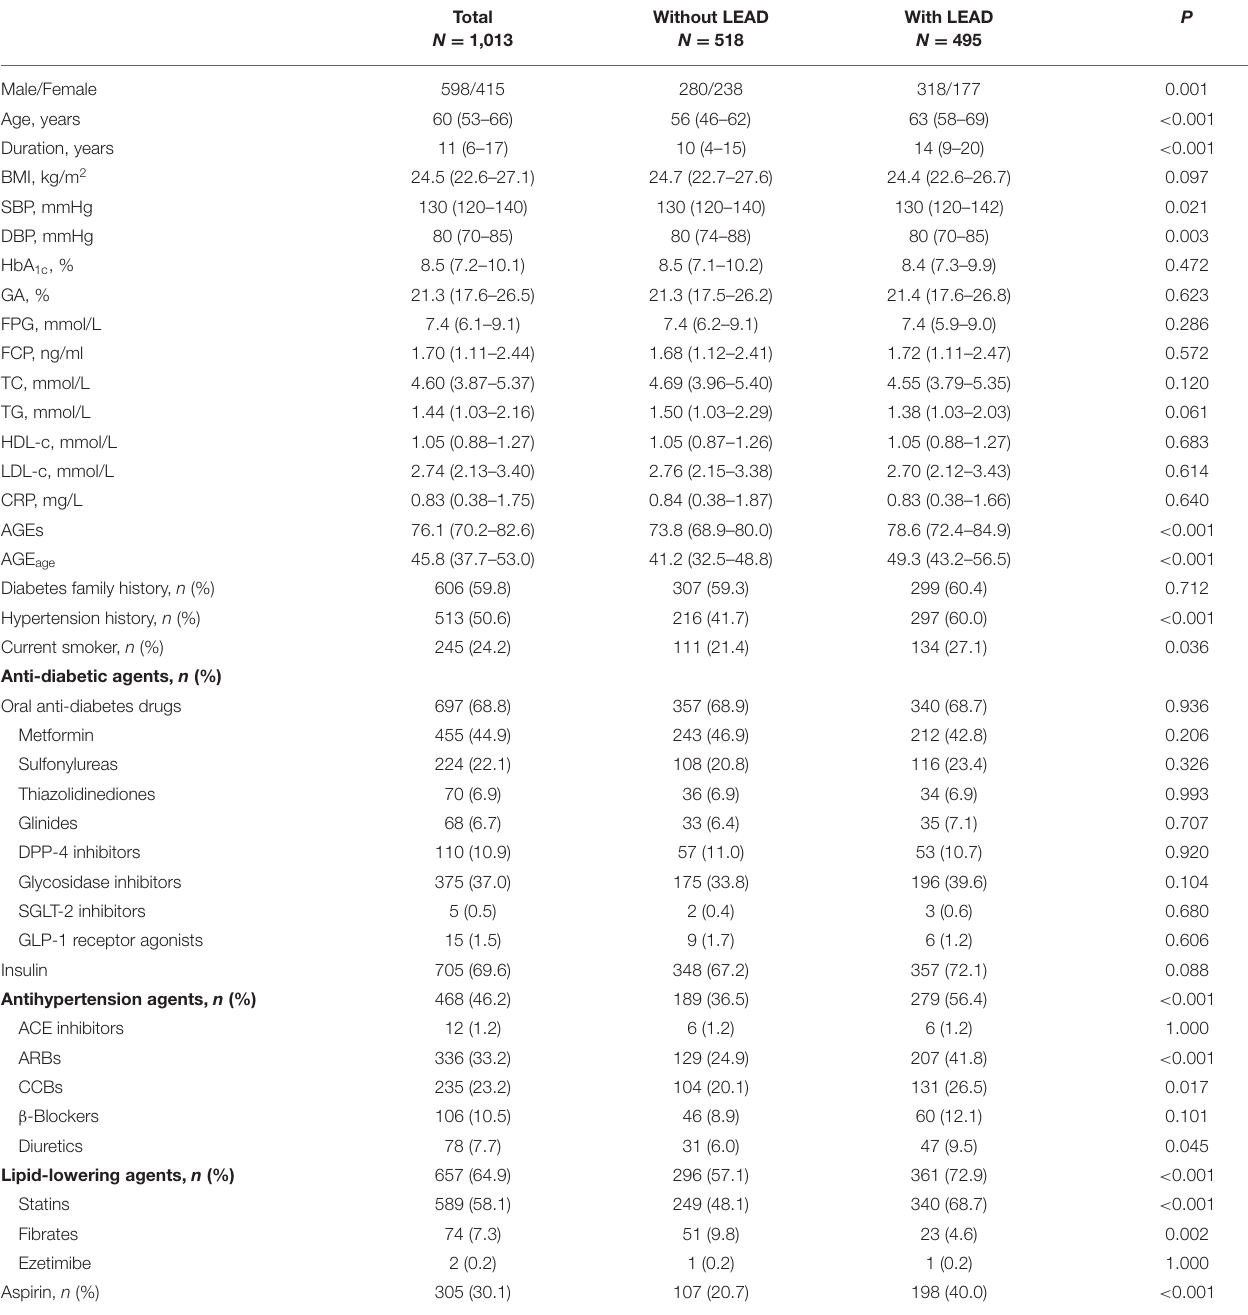
TABLE 1 | Clinical characteristics of study participants by the presence of LEAD.